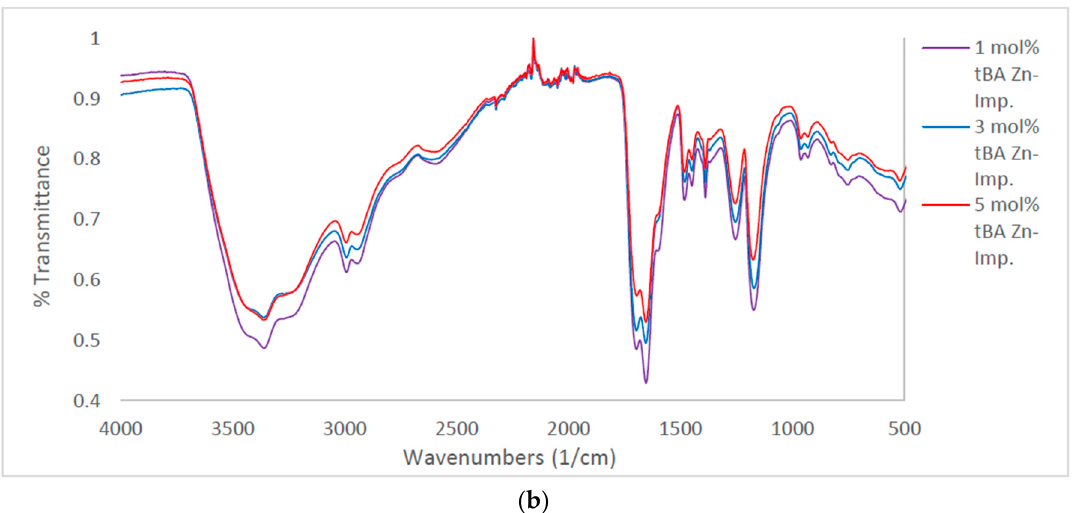
Figure 4. ( a ) Comparison of IR for non-imprinted resins with variable tBA. Spectra stacked in order of increasing tBA concentration. From top to bottom, spectra are 3, and 5 mol % tBA, respectively. ( b ) Comparison of IR for zinc-imprinted (bottom) resins with variable tBA. Spectra stacked in order of increasing tBA concentration. From top to bottom, spectra are 1, 3, and 5 mol % tBA, respectively.